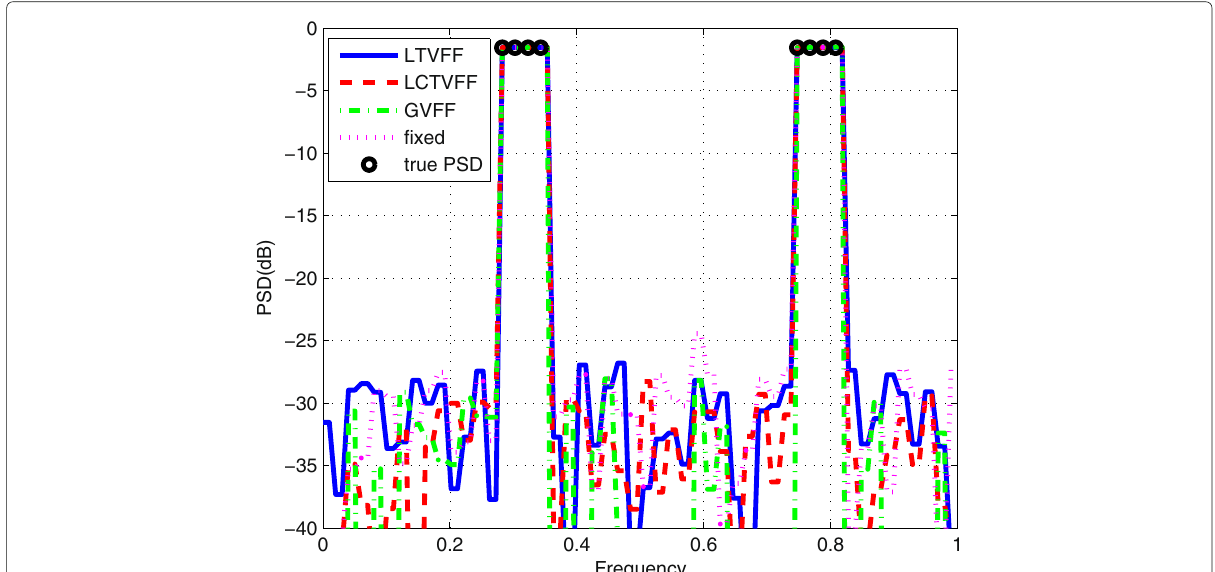
Fig. 16 PSD performance for different algorithms applied in distributed spectrum